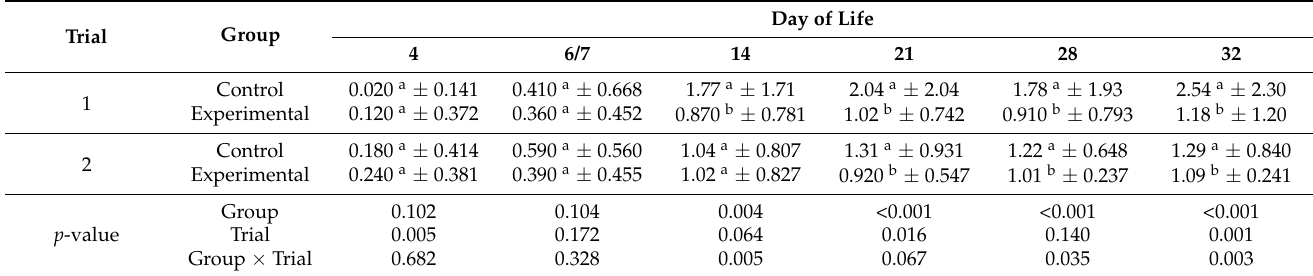
Table 4. FPD scoring of broilers depending on different diets and different trials ( n = 100 each) using two-factorial analysis. Trial